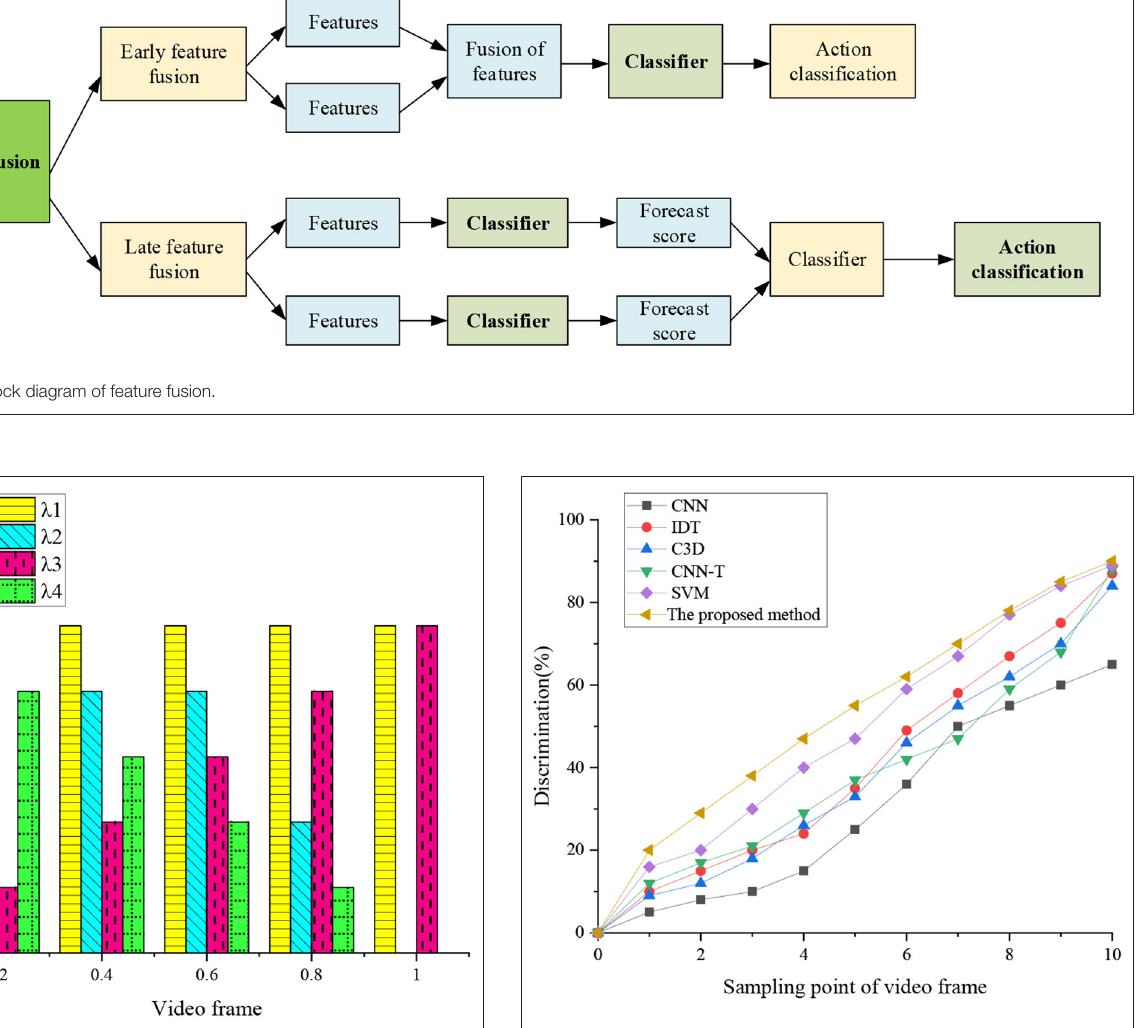
FIGURE 10 | Comparison of large-scale data processing capabilities of different